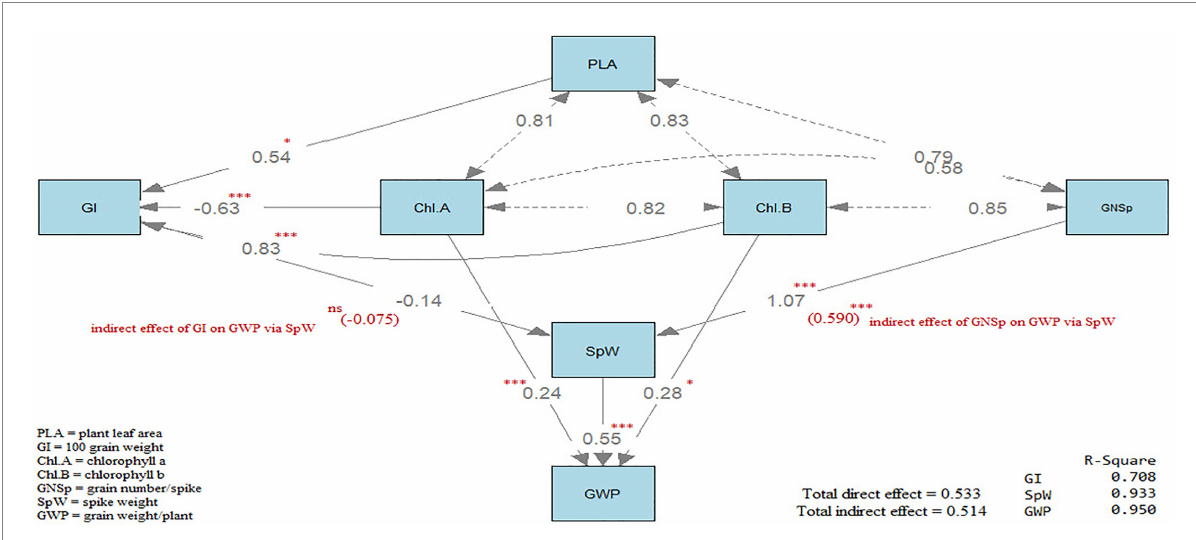
FIGURE 3 Path diagram showing the direct and indirect effects on wheat grain yield.